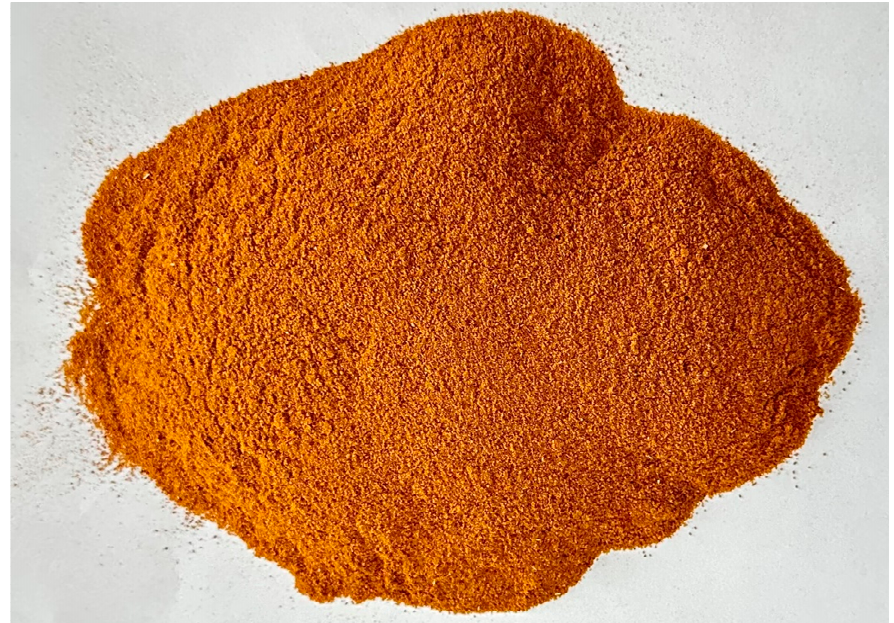
Figure 1. Dried jujube fruit powder.